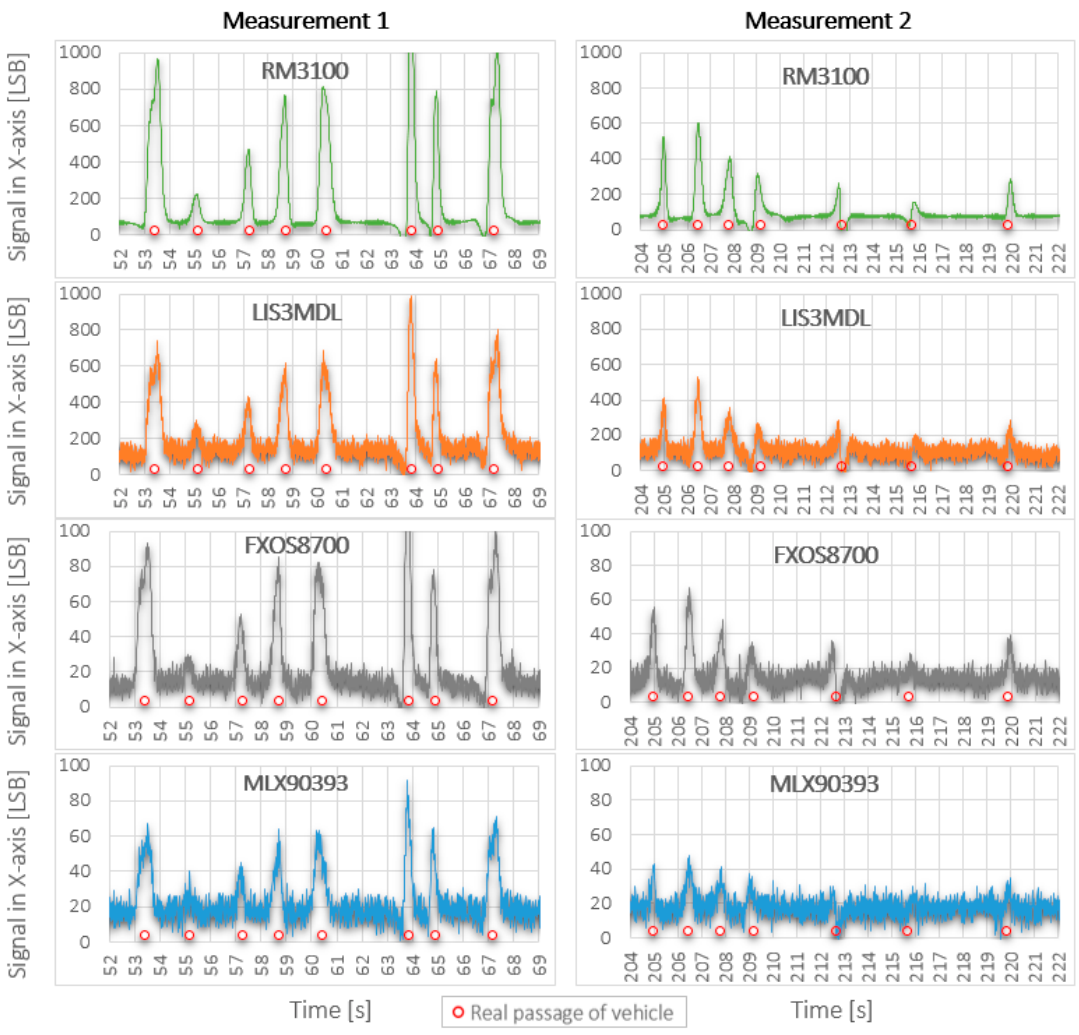
Figure 5. Comparison of recorded data by all sensors during both test measurements.